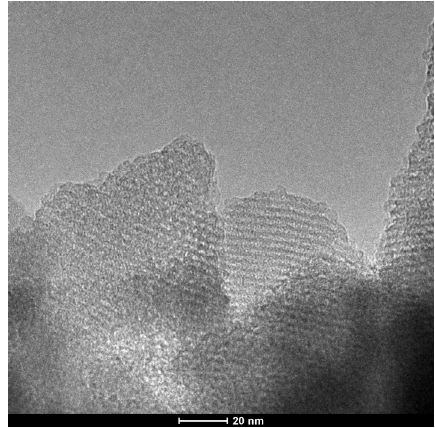
Figure 4. TEM image of uf-P@m-SiO 2 .